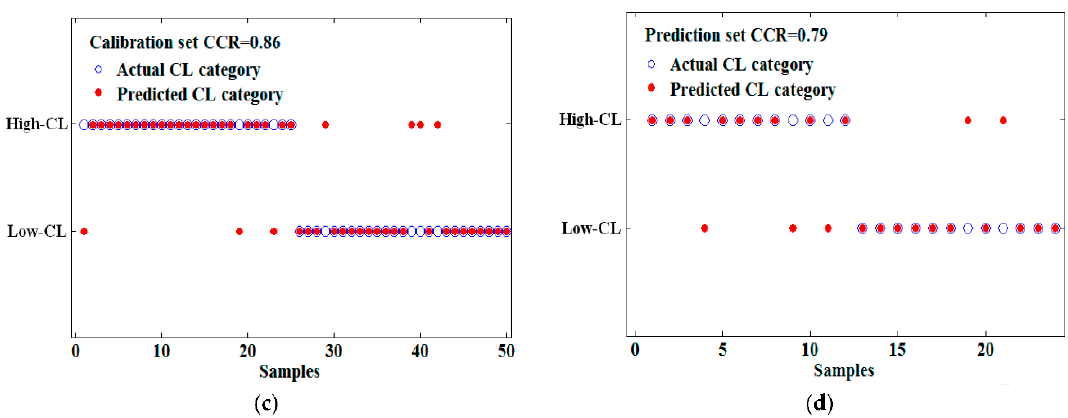
Figure 7. Performance of the full-wavelength PLS-DA model and the CARS-PLS-DA model. ( a ) Calibration set of the full-wavelength PLS-DA model; ( b ) Prediction set of the full-wavelength PLS-DA model; ( c ) Calibration set of the simplified CARS-PLS-DA model; ( d ) Prediction set of the simplified CARS-PLS-DA